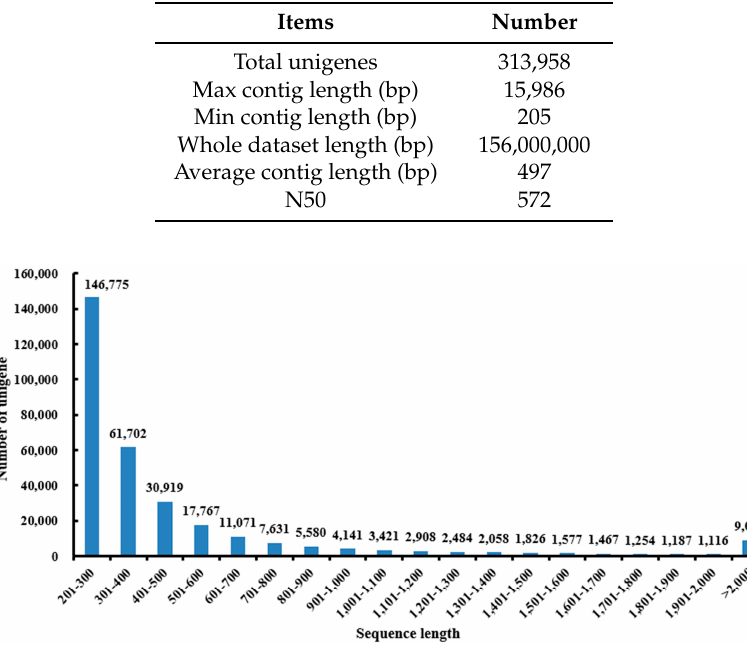
Table 2. List of annotations.